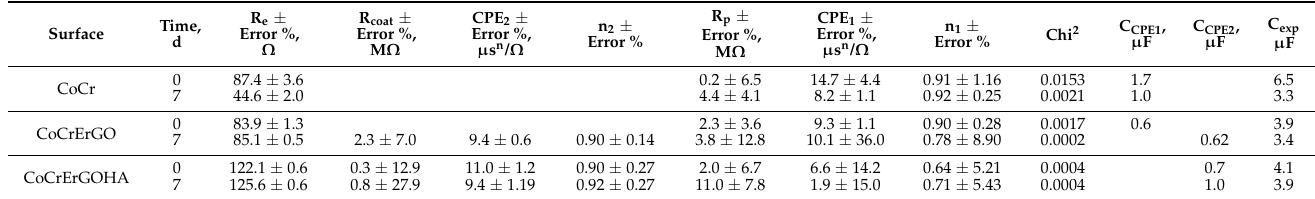
Table 1. Fitting values of the experimental impedance data by using the equivalent circuits of Figure 3. R e —electrolyte resistance; CPE 1 —constant phase element and R p —resistance related to metal surface/electrolyte interface; CPE 2 —constant phase element and R coat —ionic resistance due to the films deposited on the CoCr surface. C exp —experimental capaci- tance calculated in the high-frequency region (Equation (2)), C CPE1 and C CPE2 —capacitance calculated from CPE values (Equation (1)), only for n ≥